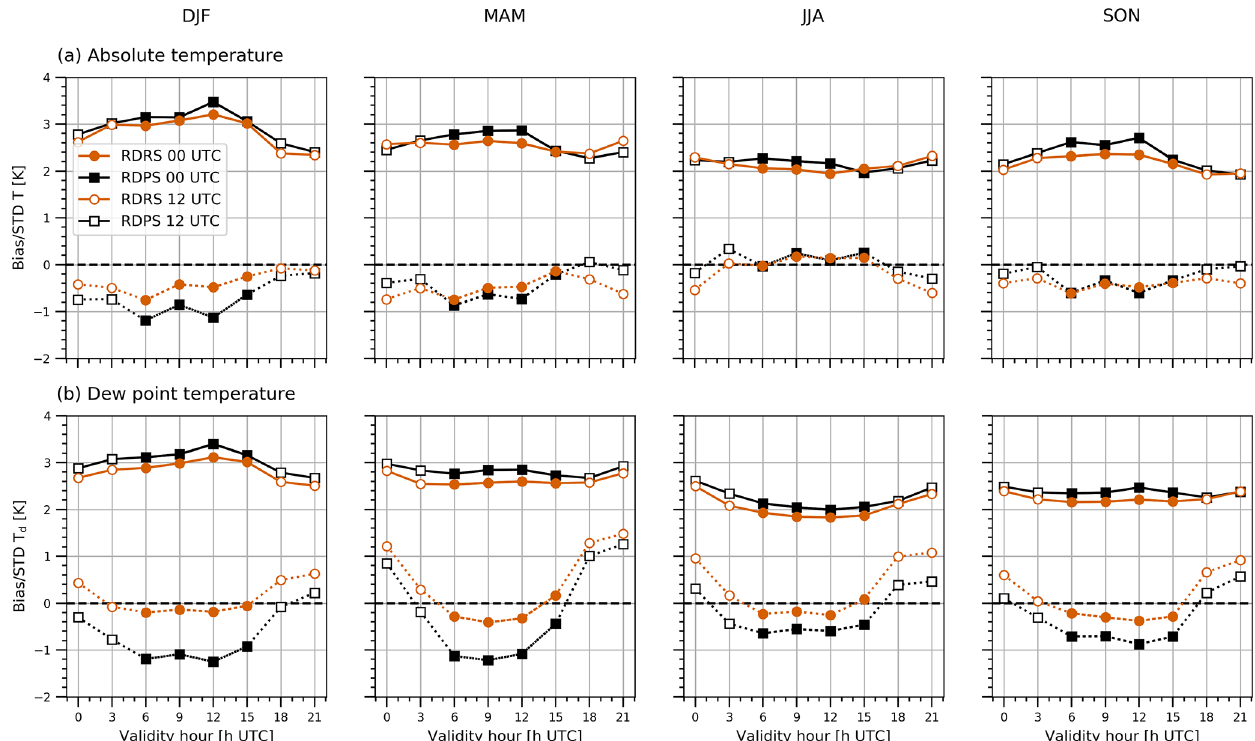
Figure 7. Seasonal diurnal cycles of surface results from operational RDPS (black with square markers) and RDRS-10 (orange with round markers) against SYNOP observations in terms of STDE (top curves, solid lines) and bias (bottom curves, dashed lines) for entire North America over the period 2011–2017; from left to right: winter (DJF); spring (MAM); summer (JJA); autumn (SON); (a) absolute temperature; (b) dew point temperature. Results are only based on the 6 to 17h lead time from integrations starting at 00:00UTC (filled markers) and 12:00UTC (empty